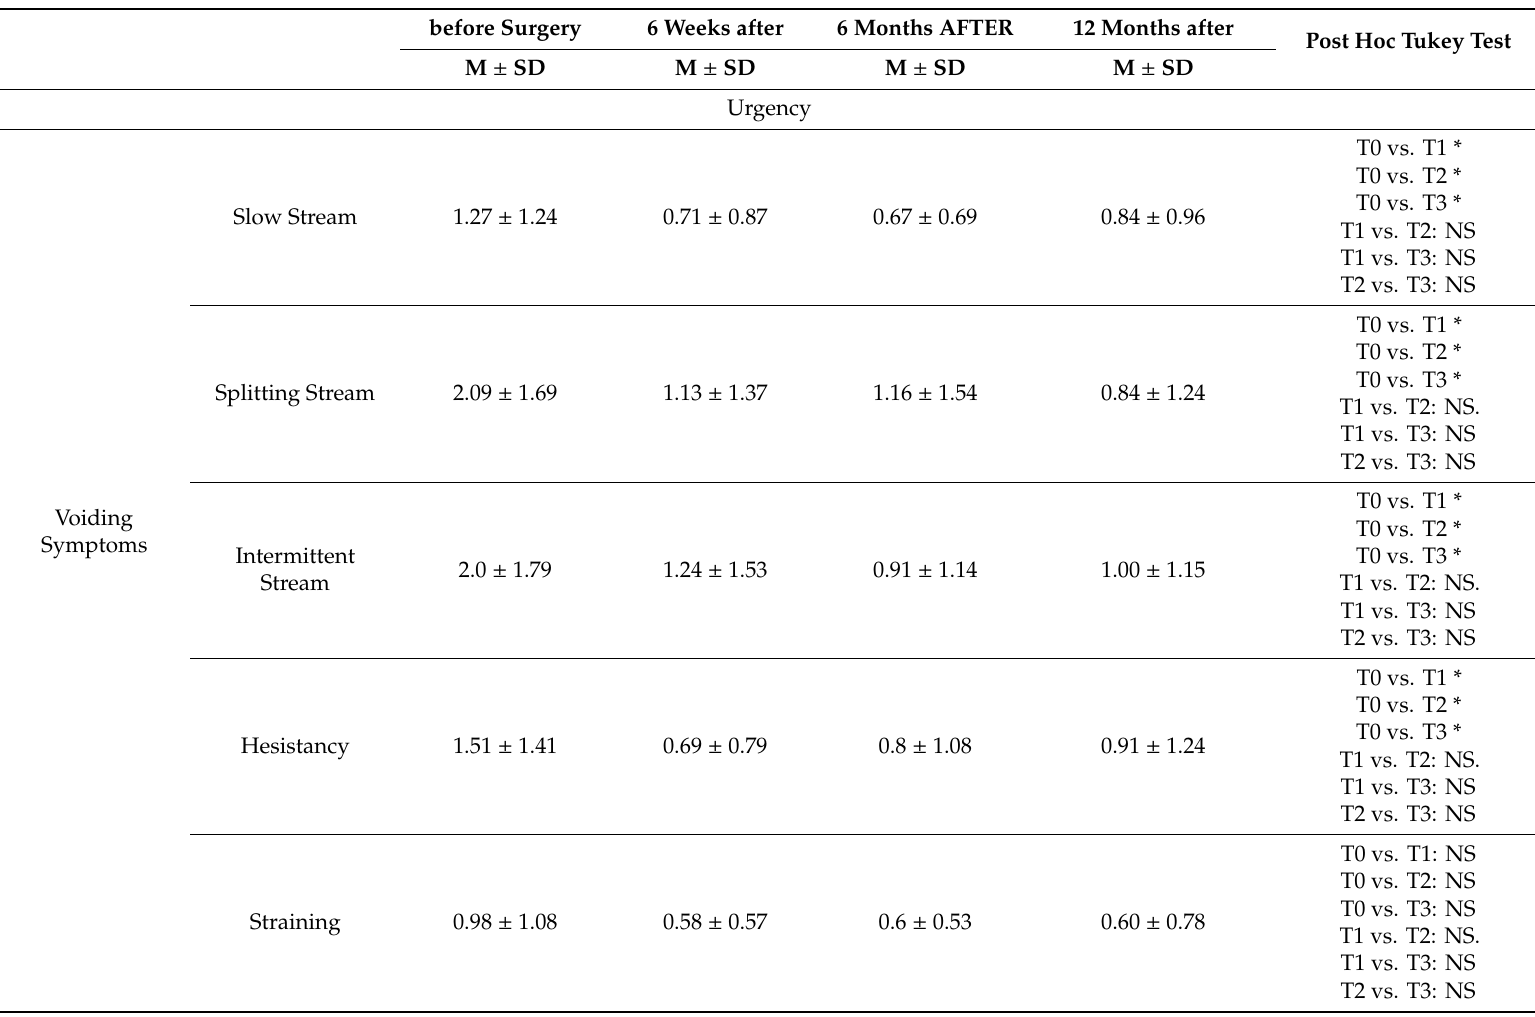
Table 3. Results of the LUTS questionnaire assessing the severity of the functional disorders of the voiding phase and the post-voiding phase. before